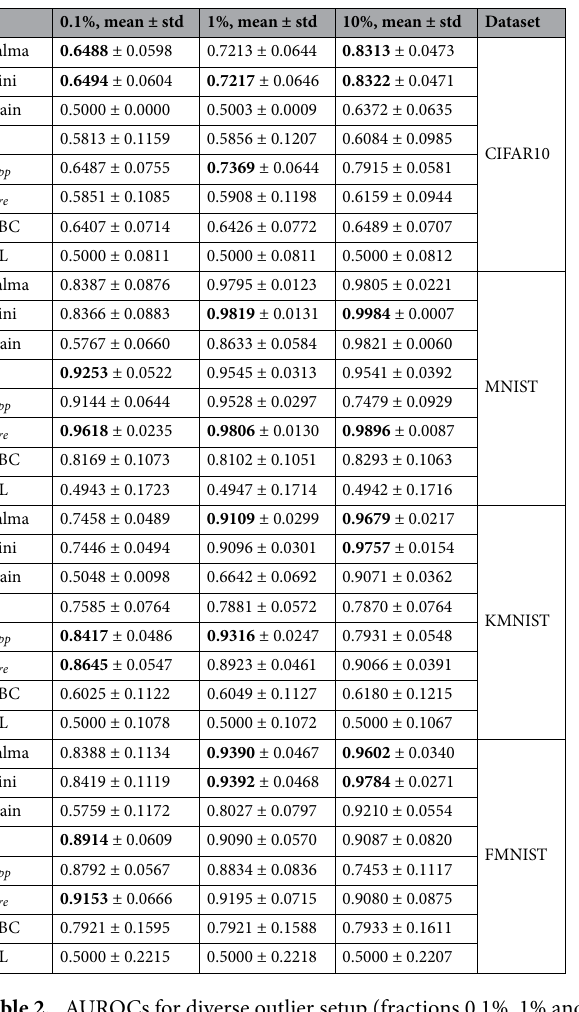
Table 2. AUROCs for diverse outlier setup (fractions 0.1%, 1% and 10%). The best and the second-best results are in